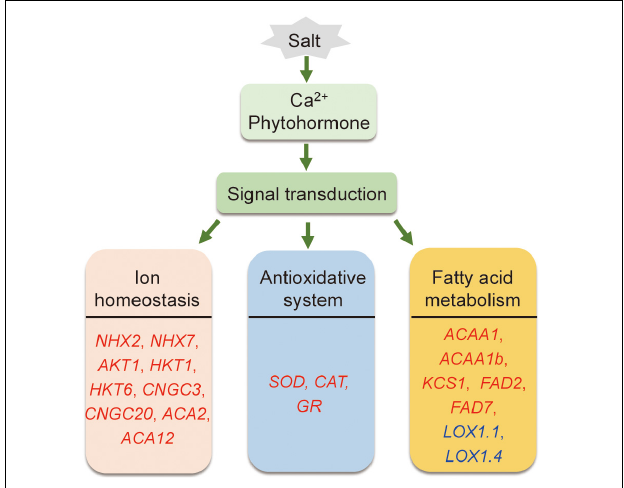
FIGURE 10 | A proposed model showing salt tolerance mechanisms in alfalfa. Salt tolerance in alfalfa is associated with regulation of ionic homeostasis, antioxidative enzymes and fatty acid metabolism. Red and blue genes are proposed positive and negtive regulatory genes in salt